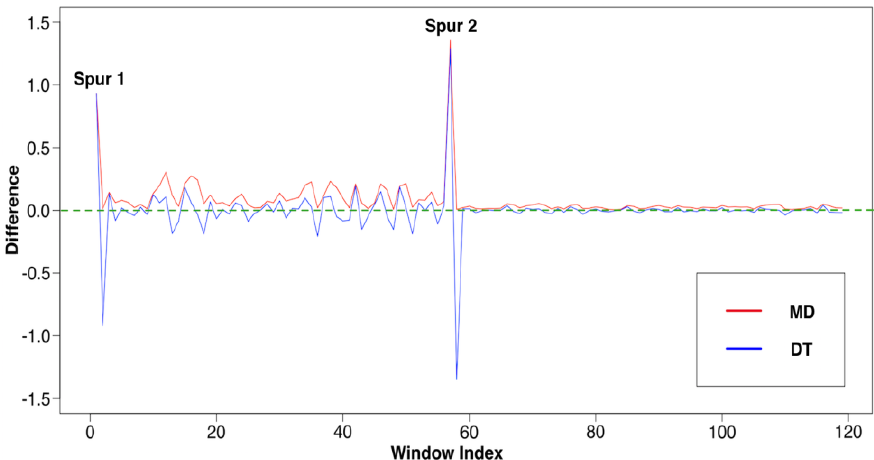
Figure 15. Trajectories of MD and DT.